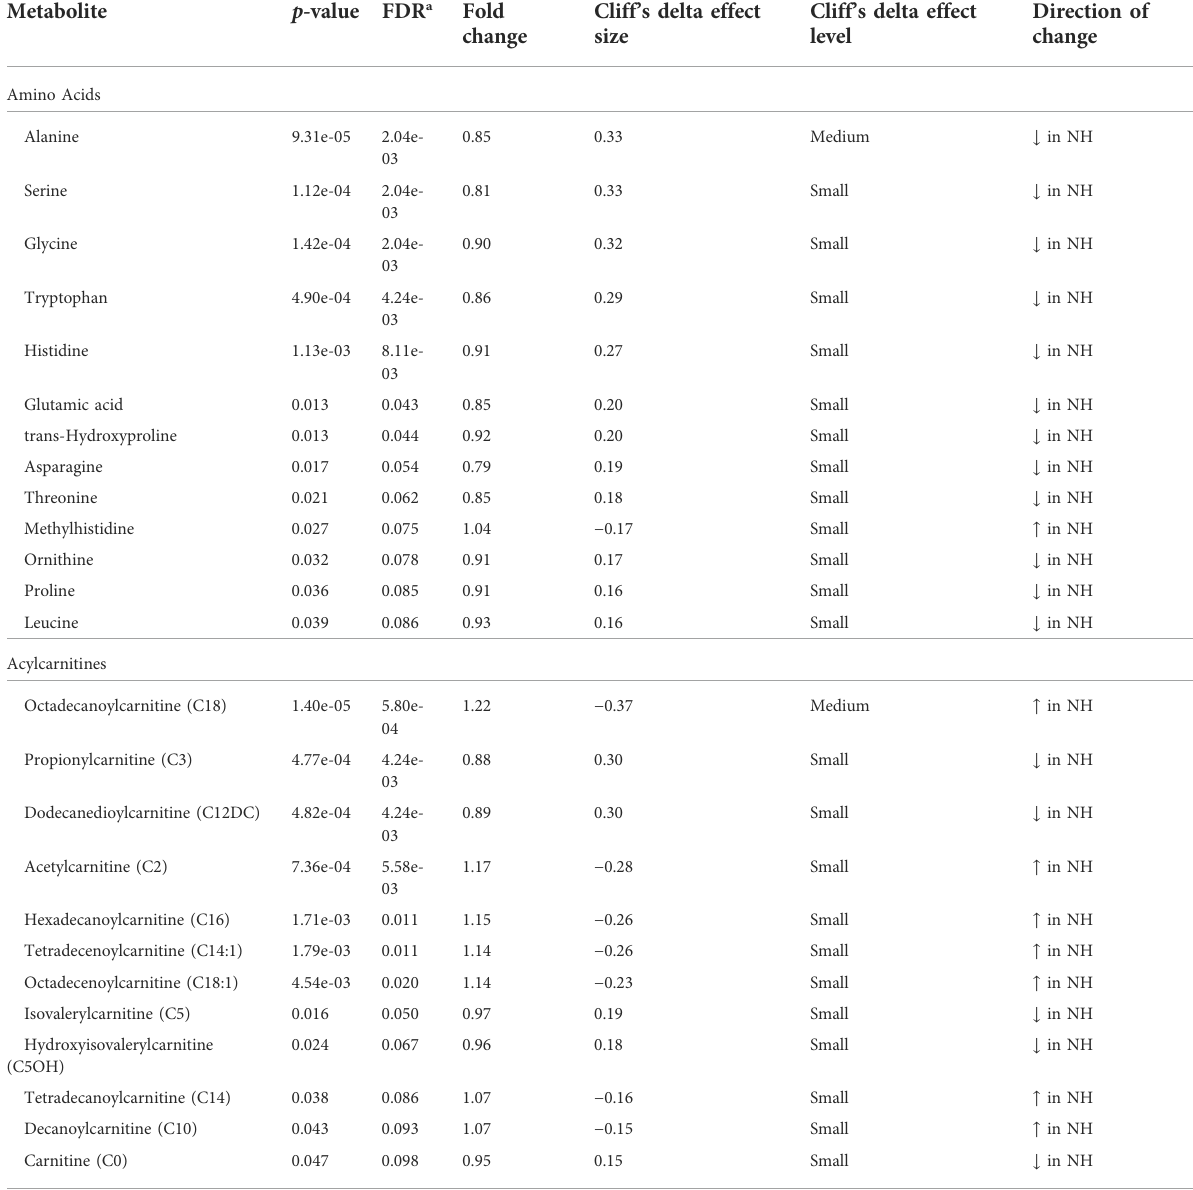
TABLE 1 Amino acids and acylcarnitines signi fi cantly ( p < 0.05) affected by treatment (H = Habituated; NH = Non-habituated) in